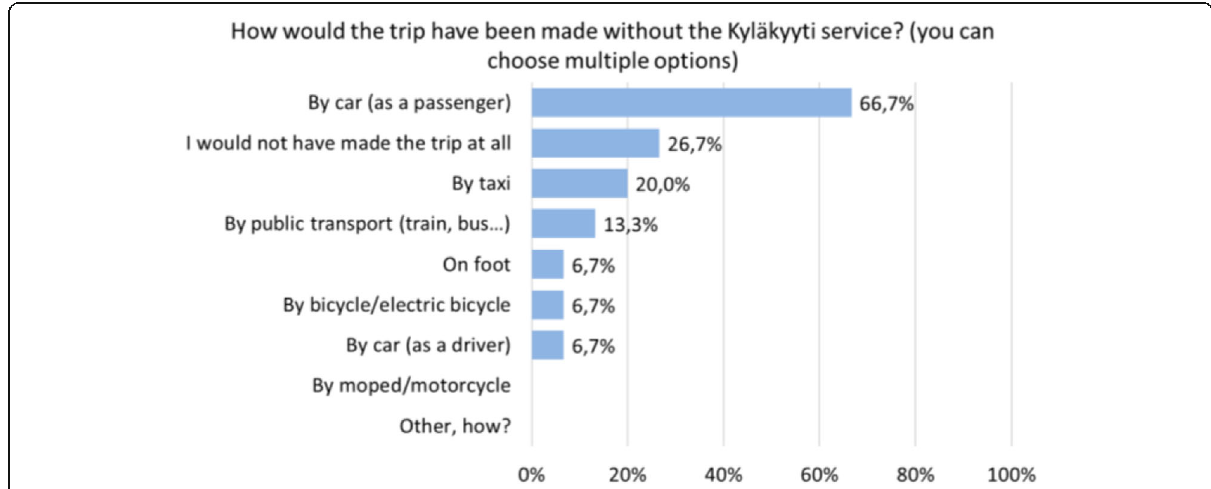
Fig. 8 Transport modes replaced by Kyläkyyti ( n =